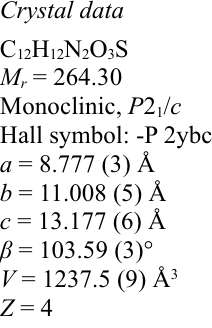
Figure 1 ORTEP - 3 (Farrugia, 1997) drawing of the title molecule with displacement ellipsoids plotted at 50% probability level. Ethyl 2-(5-phenyl-1,3,4-oxadiazol-2-ylsulfanyl)acetate Crystal